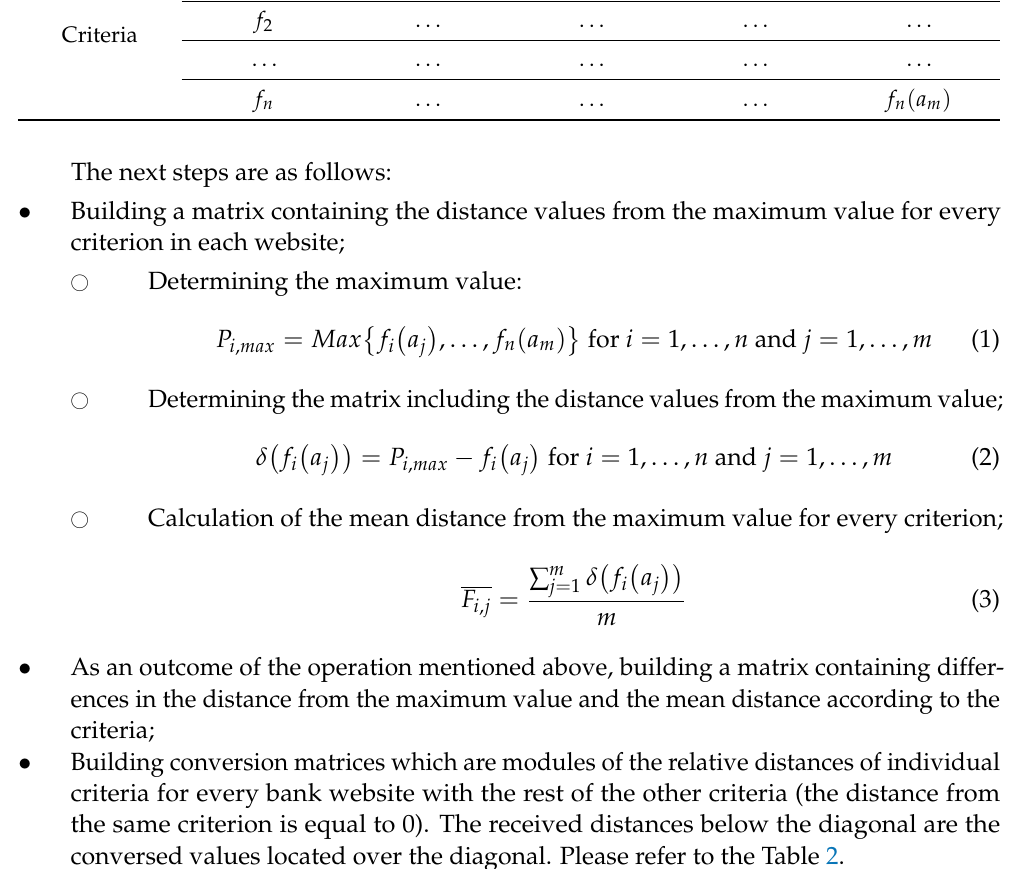
Table 1. The experts’ table of assessments of particular criteria for each website. Websites a 1 a 2 . . . a m f 1 f 1 ( a 1 Criteria